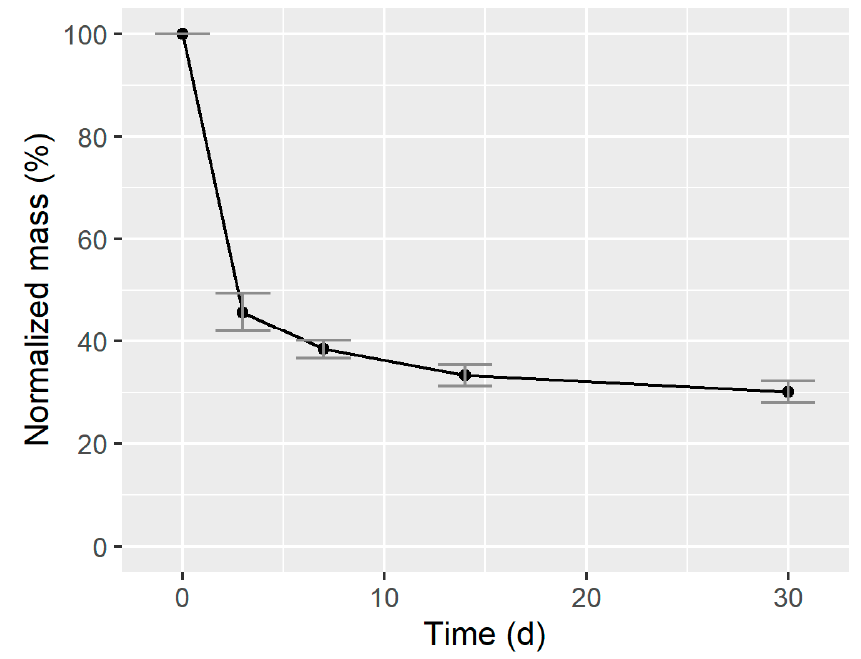
Figure 2. Overall mass loss from bags from the batch anaerobic digestion experiment using CGP as substrate. Error bars show standard deviation ( n = 3).